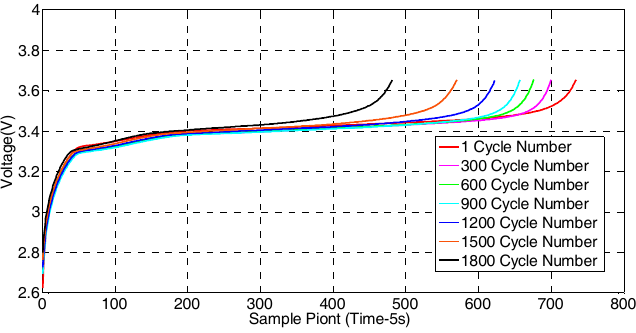
Figure 2. Batteries’ charge terminal voltages under different cycle numbers.